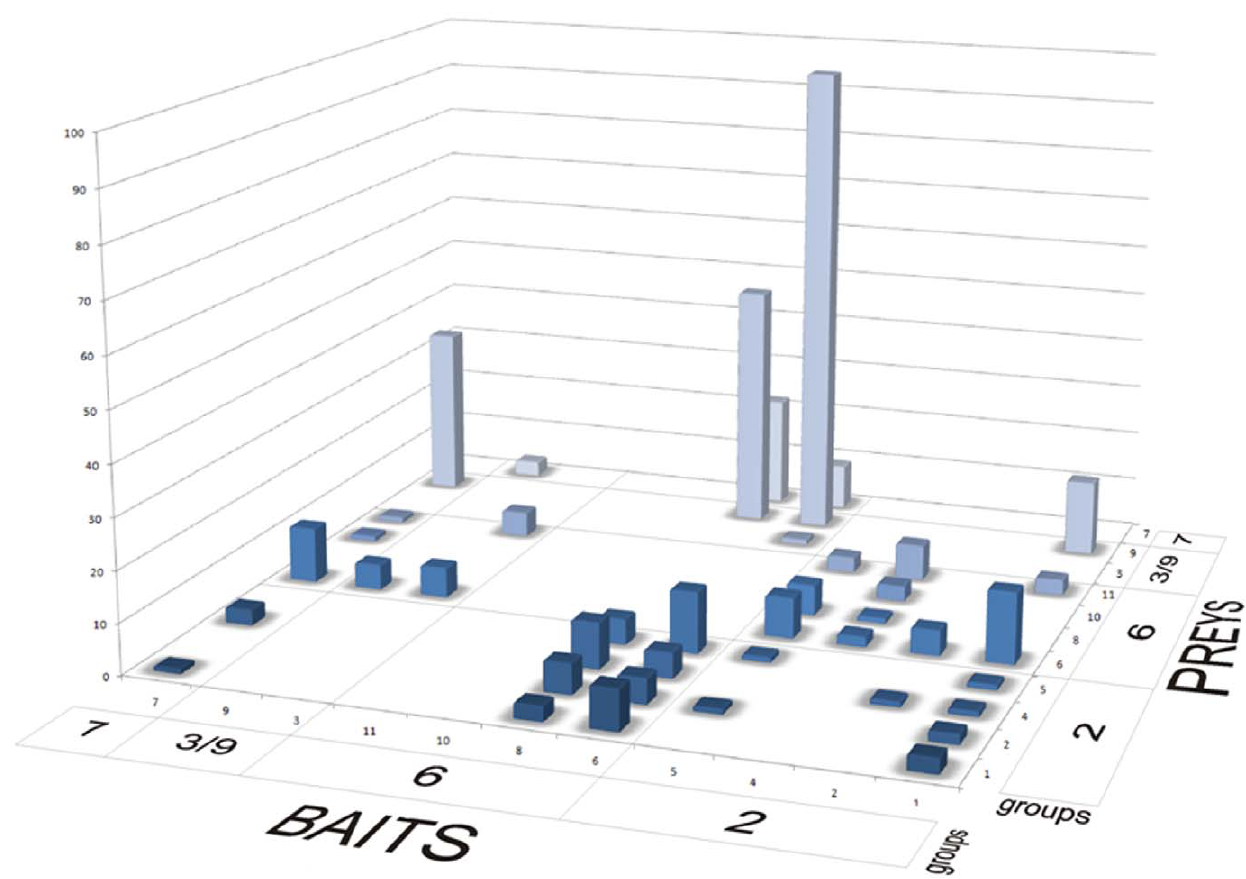
Figure 2. Three dimensional column diagram of the number of clones of septin prey proteins fished by septin bait proteins in group wise organization. Number of fished clones for each prey septin (Y-axis), was plotted against bait (X-axis) and prey septins (Z-axis), where the septins have been ordered in a group wise fashion (See Table S1 for raw data of clone numbers). The whole distribution is significantly (p=0.0004998) different from a random distribution, as can also be verified visually, since the clone numbers group into ‘‘islands’’ in between various blank areas. When we compared groups in a one-to-one and reciprocal fashion we obtained significant p-values (p , 0.001), suggesting a non-random distribution, for the following pairs of groups: group 2 vs. group 6, group 6 vs. group 3/9, group 6 vs. group 7, and group 3/9 vs. group 7. Furthermore, we can still analyze the occurrence of interactions among septins of the same group. The result in this case is obvious: members of groups 6, 3/9 and 7 never interacted with themselves or with other members of the same group. The only exception is group 2, which members tended to interact with other group 2 members. See also Fig. 3.